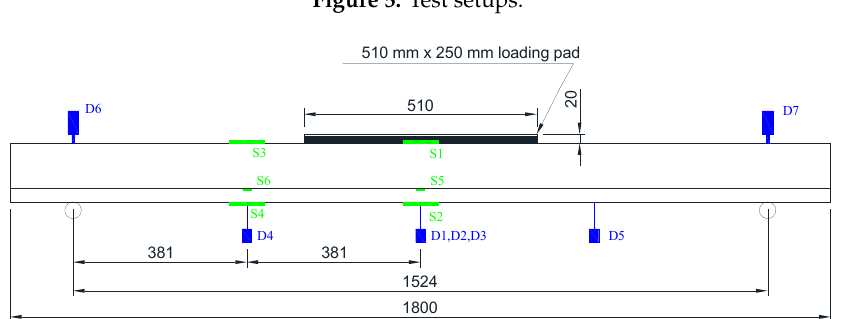
Figure 5. Test setups.